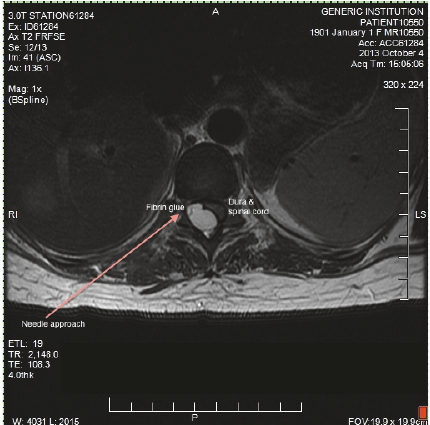
Figure 3: Axial T2 postinjection MRI demonstrating extradural hydrogel sealant deposition with leftward displacement of the thecal sac and spinal cord at